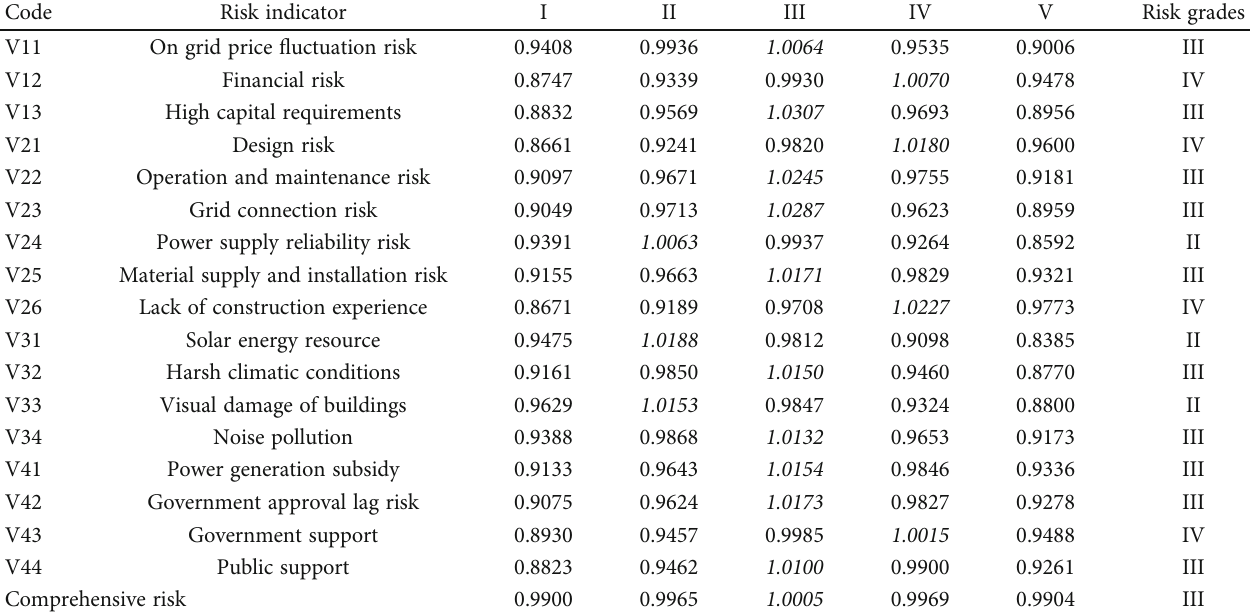
Table 8: The proximity degree of each risk indicator and risk grades of each risk